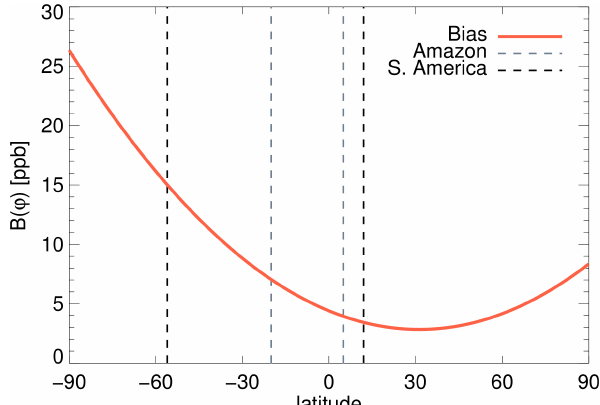
Figure A1. Model–satellite bias function B(ϕ) (red line) varying with latitude, ϕ . This value is added to the simulated XCH 4 to enable comparison with the GOSAT XCH 4 . See main text for details. Vertical grey and black dotted lines show the latitudinal extent of the Amazon basin and South America, respectively.